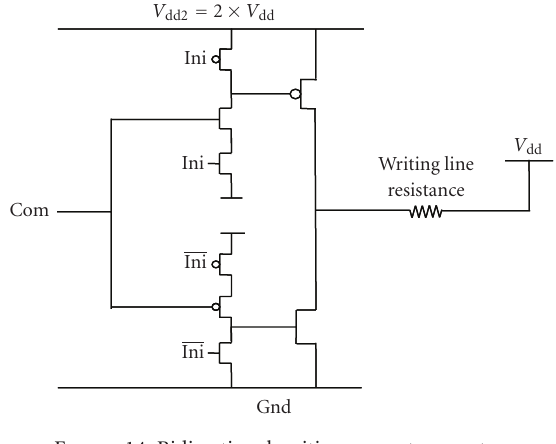
Figure 14: Bidirectional writing current generator.